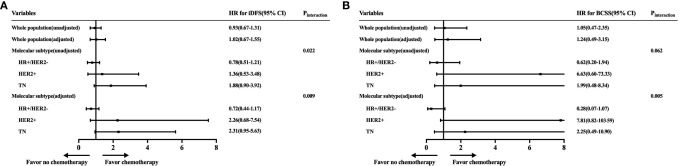
Forest plot of unadjusted and adjusted hazard ratios of invasive disease-free survival (iDFS) and breast cancer-specific survival (BCSS) rates according to molecular subtype. The unadjusted estimates were from the Cox models with only the exposures of interest. The adjusted models were estimated by incorporating factors that would influence a clinician’s decision to offer adjuvant chemotherapy: molecular subtype, age, tumor grade, and tumor size.